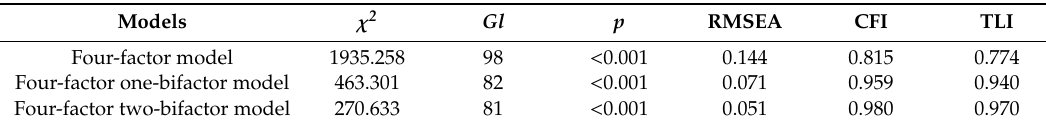
Table 1. Goodness of fit indices of alternative